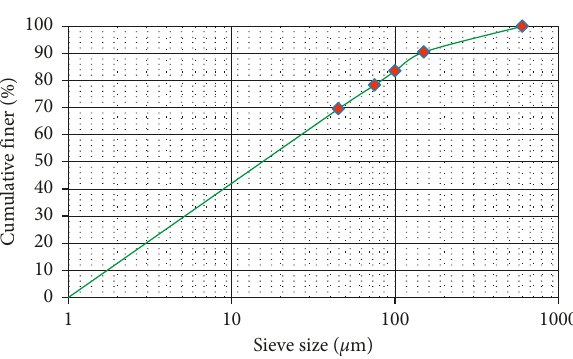
Figure 2: Iron tailings powder distribution